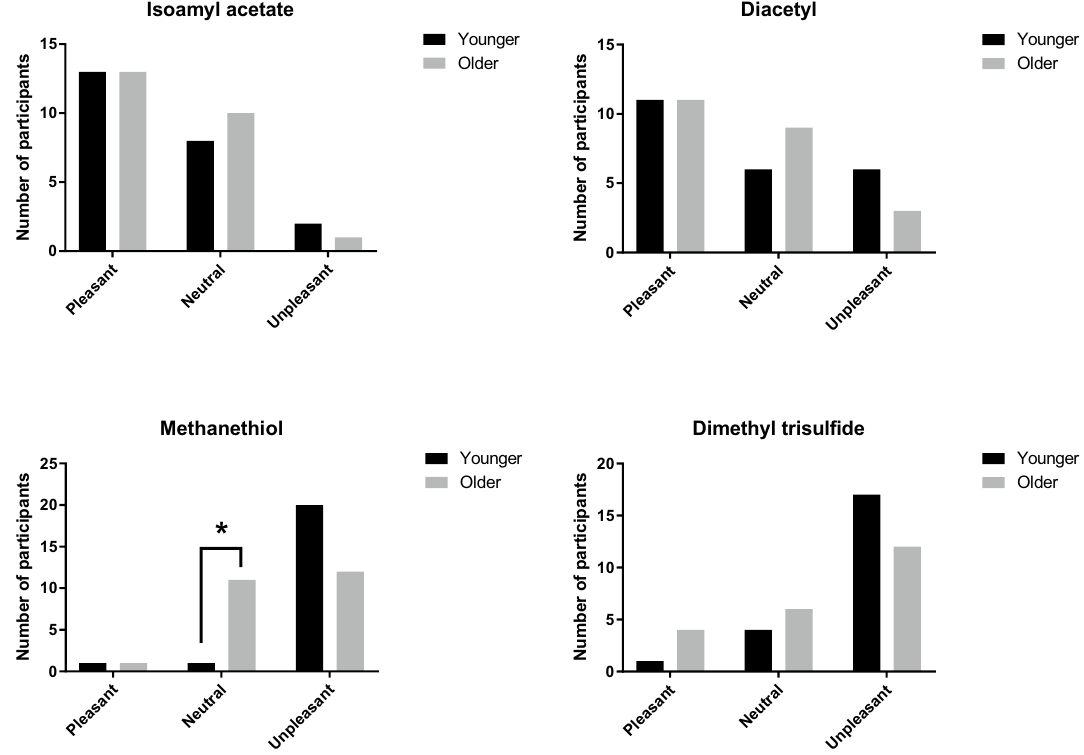
Figure 4. Pleasantness ratings of the aroma compounds, separated by both older and younger adults, for the four aroma compounds studied. Statistically significant differences, as analysed by the Chi-squared test, are marked with * for p <